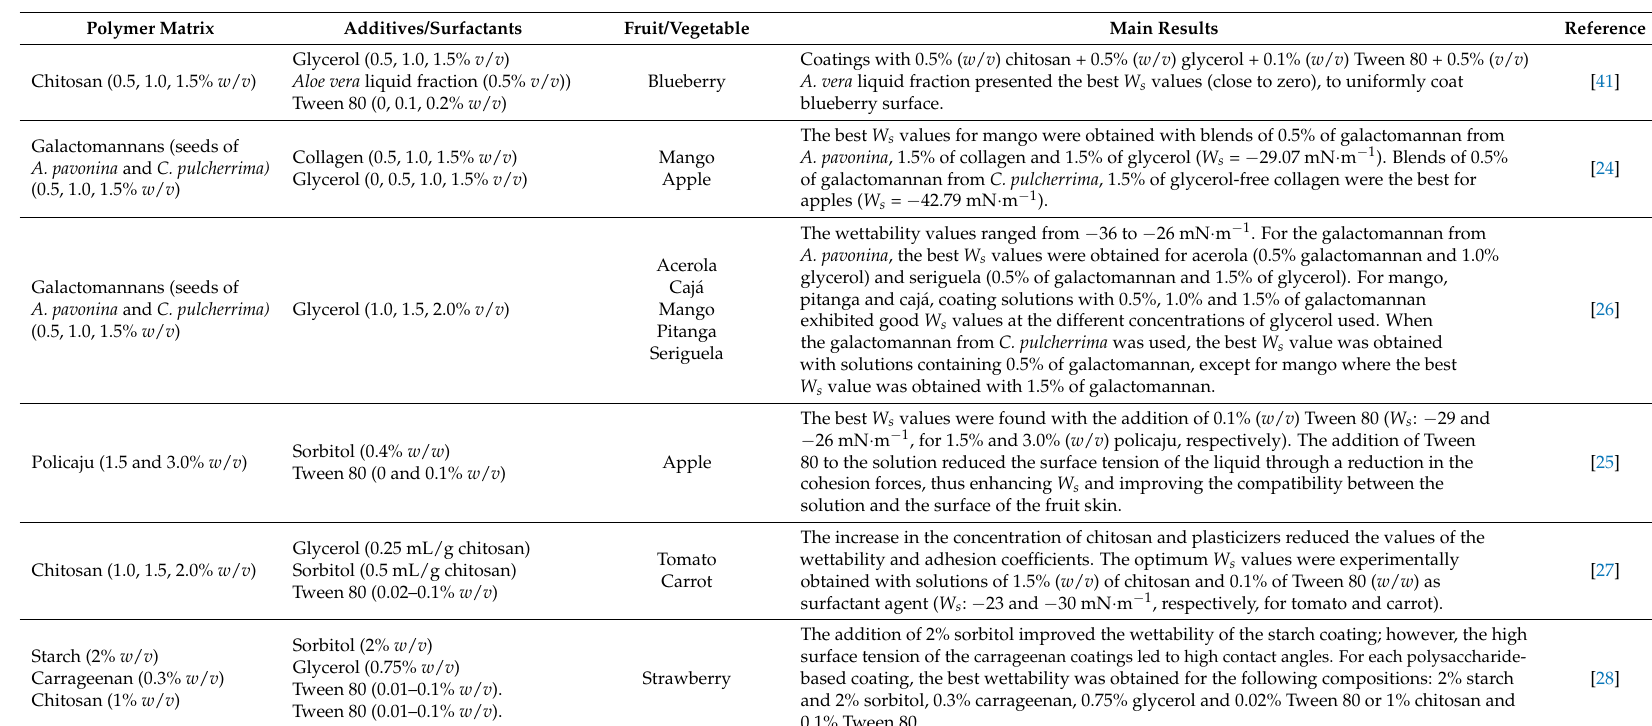
Table 2. Recent studies into the effect of different components and concentrations on the surface properties of coatings and their spreading coefficient ( W s ) on